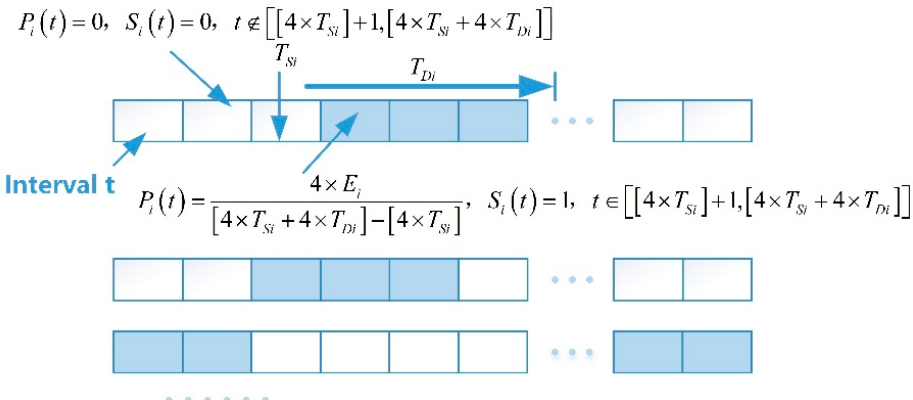
Figure 2. Discrete processing of charging records. Where P i ( t ) is the load value generated during the interval t using constant charging power, t = 1, 2, · · · , 96. When S i ( t ) is 1, the EV is in the charging connection state and can be charged. The total load curve of the m -th type of charging record L m ( t ) = ∑ and T m C